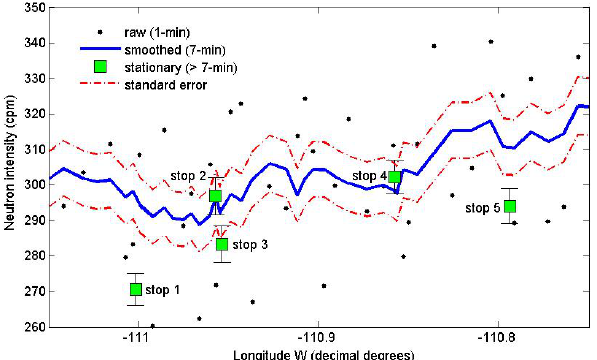
Fig. 2. Raw (one-minute), smoothed (seven-minute running aver- ages) and stationary neutron intensity from an east–west trending transect in the Tucson Basin. The stationary points are locations where the rover was stopped; the neutron intensity was recorded for at least 7min at these stops. Stops 1, 3, and 5 are small-scale features with anomalously high soil-moisture values (low neutron count rate). Stop 1 is near a golf course, stop 3 is on the Univer- sity of Arizona irrigated campus, and stop 5 is at a wet spot in the foothills of the Santa Catalina Mountains. Fig. 3. Twenty interpolated soil moisture maps from seven-minute